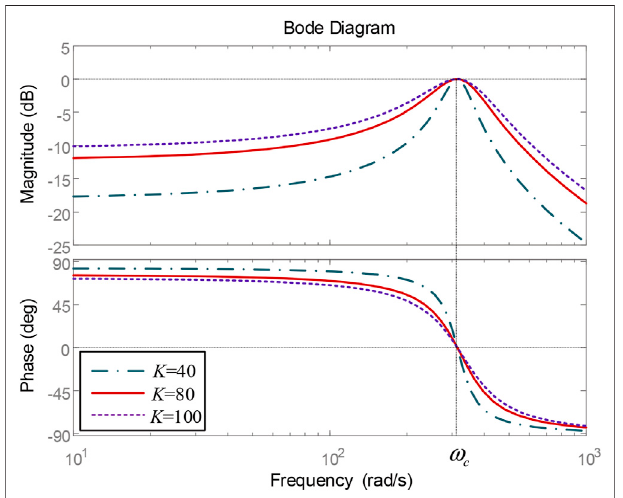
FIGURE 6 | Amplitude frequency characteristic curve of STF.